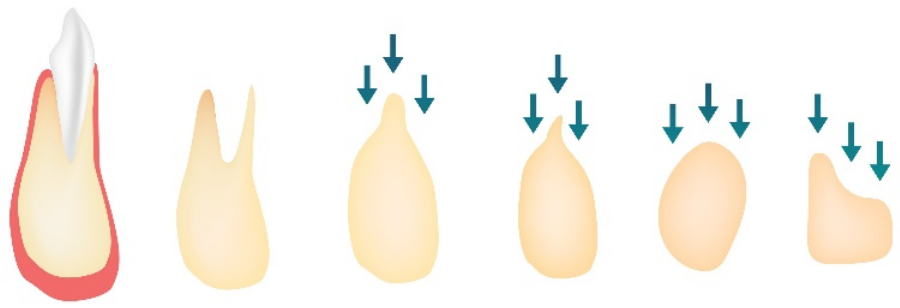
Figure 1. Stages of alveolar ridge reduction after tooth loss, order 1—pre extraction, order 2—post extraction, order 3—high, well-rounded, order 4—knife edge, order 5—low, well-rounded, order 6— depressed.